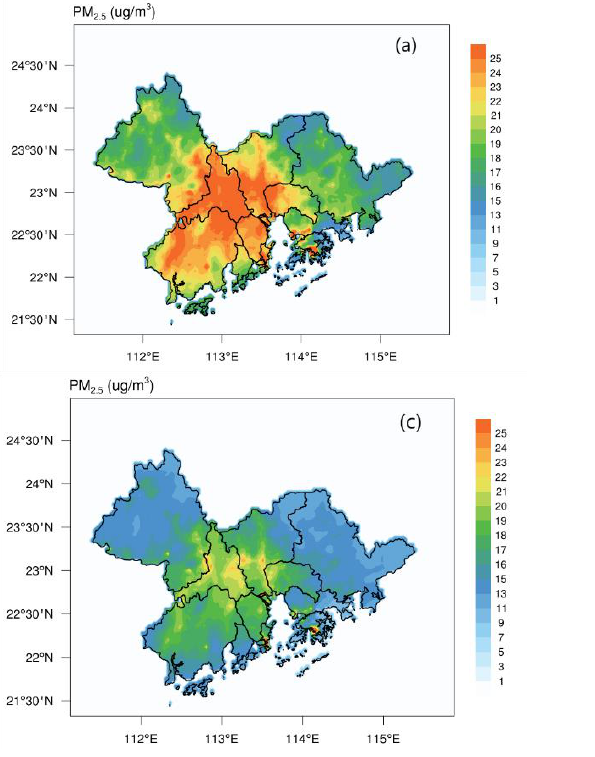
Figure 6. Spatial distributions of PM 2.5 annual mean concentrations in the GBA by 2025: ( a ) Spatial distributions of PM 2.5 annual mean concentrations in S BAU ; ( b ) Spatial distributions of PM 2.5 annual mean concentrations in S A ; ( c ) Spatial distributions of PM 2.5 annual mean concentrations in S O ; ( d ) Annual concentration of PM 2.5 in the GBA under different scenarios (GZ: